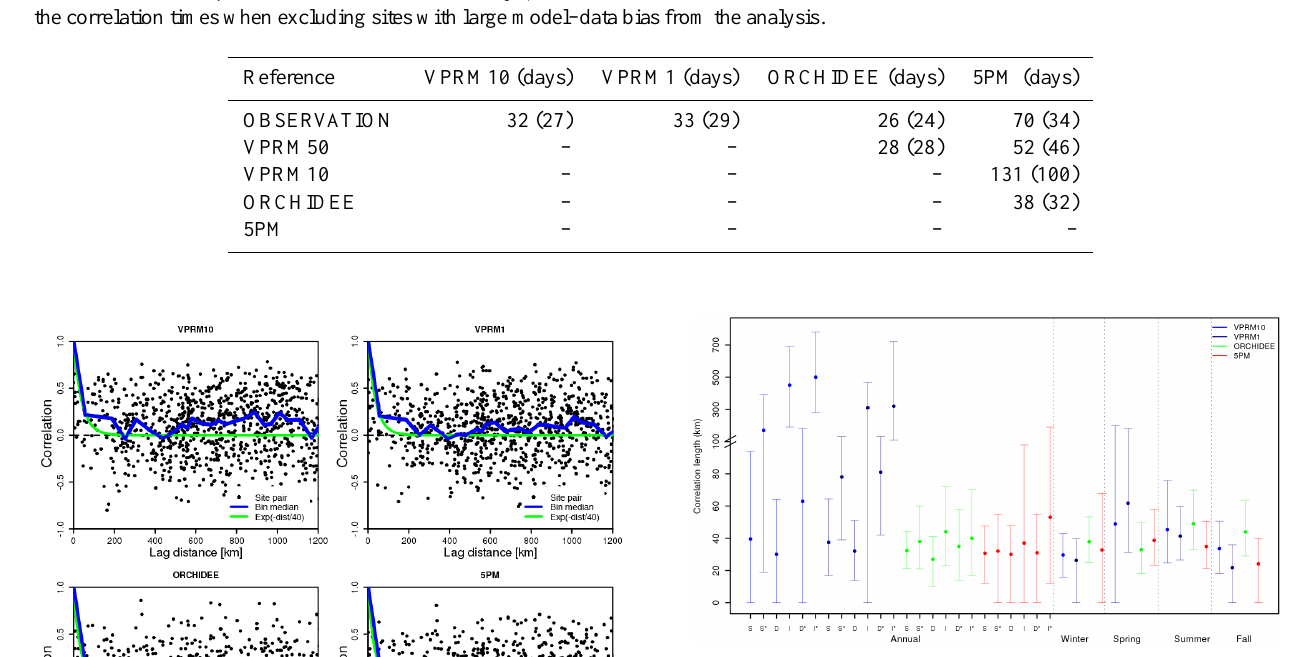
Figure 7. Annual and seasonal e-folding correlation length of the daily averaged model–data NEE residuals for VPRM at 10 and 1km resolution, ORCHIDEE and 5PM. S refers to the standard case where all pairs were used, D refers to the case where only pairs with different vegetation types were used, I denotes the case in which only pairs with identical vegetation type were considered, and ∗ de- notes that in addition 150 days of common non-missing data are required for each pair of sites. The dot represents the best-fit value when fitting the exponential model. The upper and the lower edge of the error bars show the 2.5 and 97.5 percentiles of the length value. Note the scale change in the y axis at